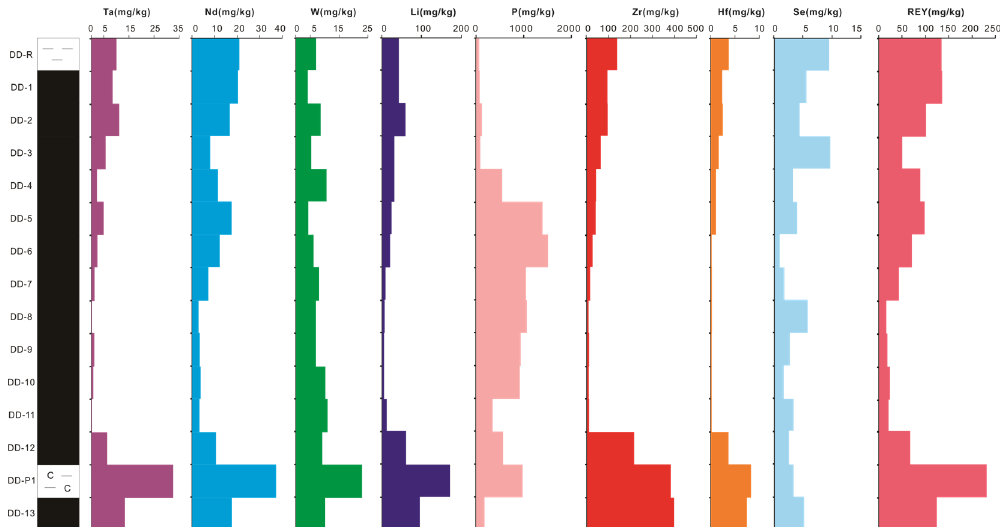
Figure 6. Vertical distribution of elevated elements through coal benches of the Dongdong coal mines. Energies 2020 , 13 , x FOR PEER REVIEW